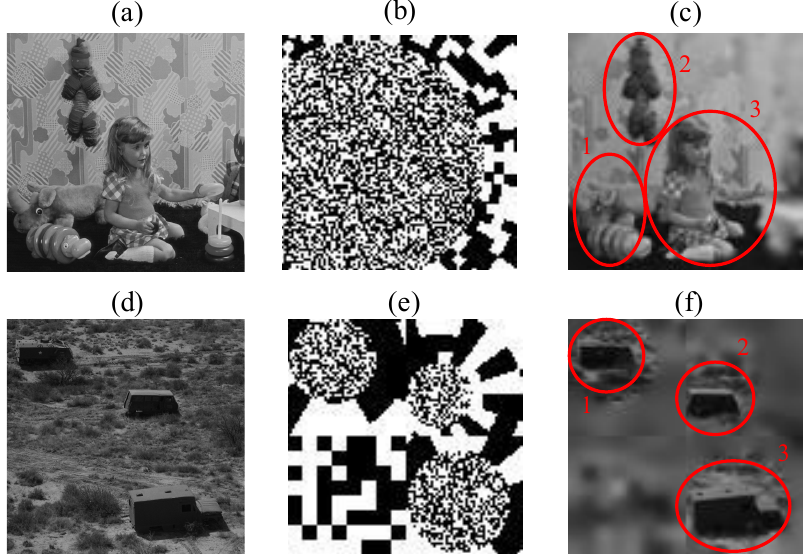
Figure 10. PRGI is applied to multiple objects. ( a ) Original image contains girl and toys; ( b ) Sample of retina-like patterns cover whole blocks; ( c ) Reconstructed image contains the girl and toys; ( d ) Original image contains three trucks; ( e ) Sample of retina-like patterns cover part of blocks; ( f ) Reconstructed image contains the three trucks.